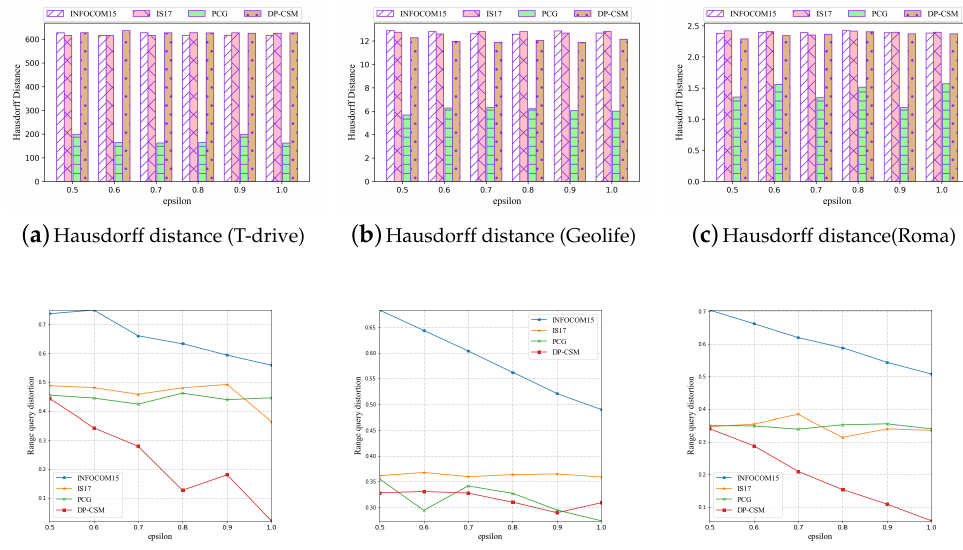
Figure 10. Impacts of privacy budget (cid:101) on data utility. We use the Hausdorff distance and range query distortion to quantify data utility of sanitized trajectory datasets resulting from the four